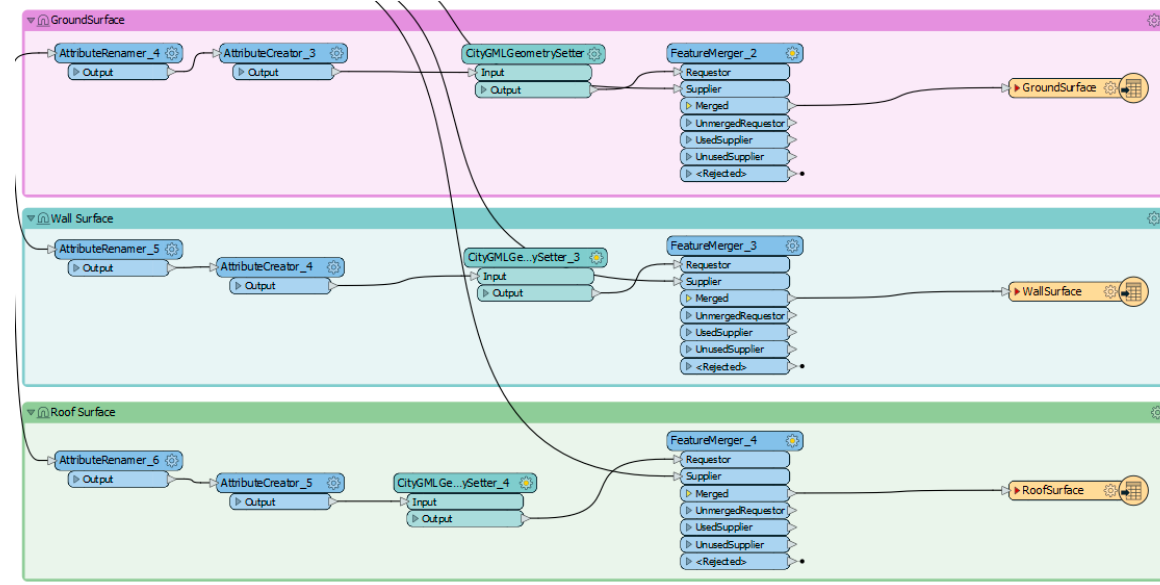
Figure 9. Surface creation for CityGML conducted in FME.